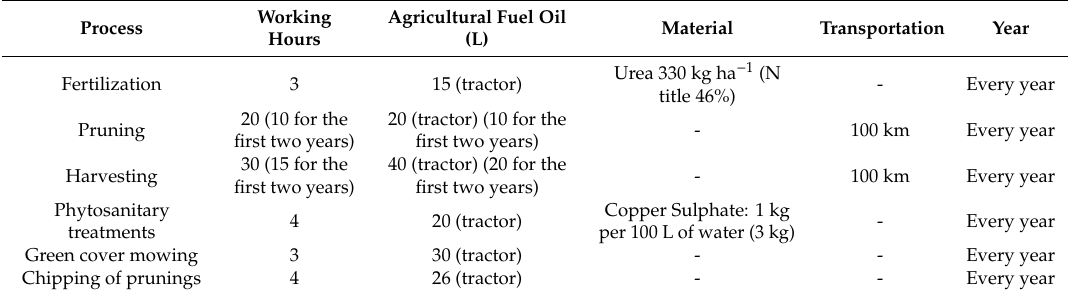
Table 1. Processes considered in Water Footprint (WF)